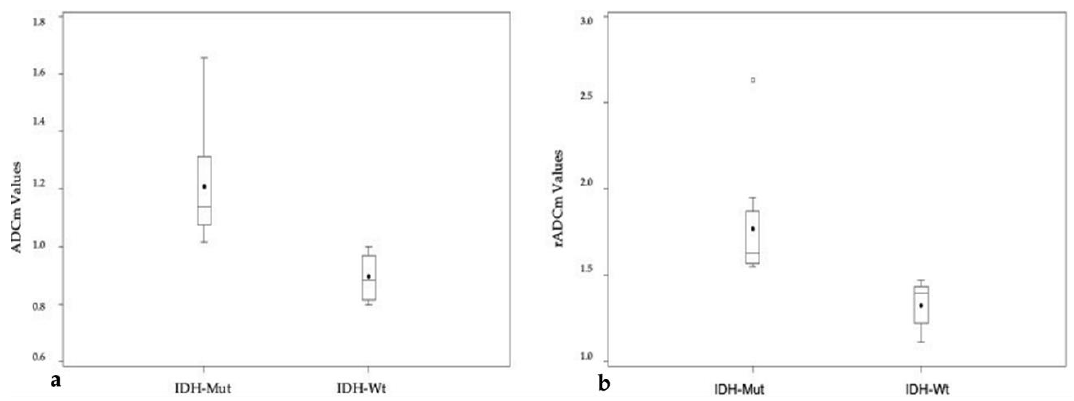
6 of 12 Figure 3. Pre-surgical conventional MR images of two patients with Grade III astrocytoma: ( a – c ) T2- weighted, fluid-attenuated inversion recovery images (FLAIR) and T1-weighted post-gadolinium images of an IDH-mutant (Mut) tumor show a lesion on the left frontal lobe. The borders are well- defined on T2-weighted ( a ) and FLAIR ( b ) images. No areas of T1-shortening are evident after IV contrast medium administration; ( d – f ) T2-weighted, FLAIR and T1-weighted post-gadolinium of an IDH-wild type (Wt) tumor show a hyperintense T2-weighted ( d ) and FLAIR ( e ) lesion on the left temporal lobe. Ill-defined borders ( d , e ) and a blurred contrast enhancement are detected ( f ). Scale bar: